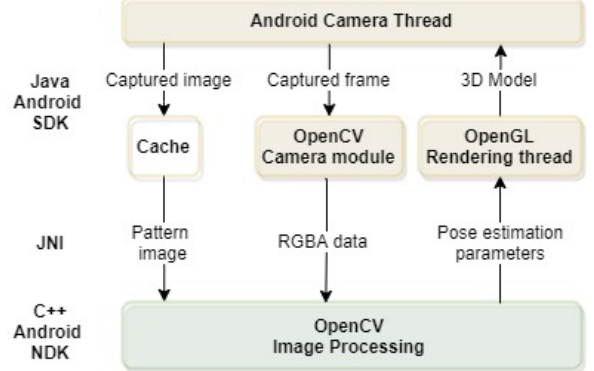
Figure 2 . System architecture, technological components and operation process of the AR application.